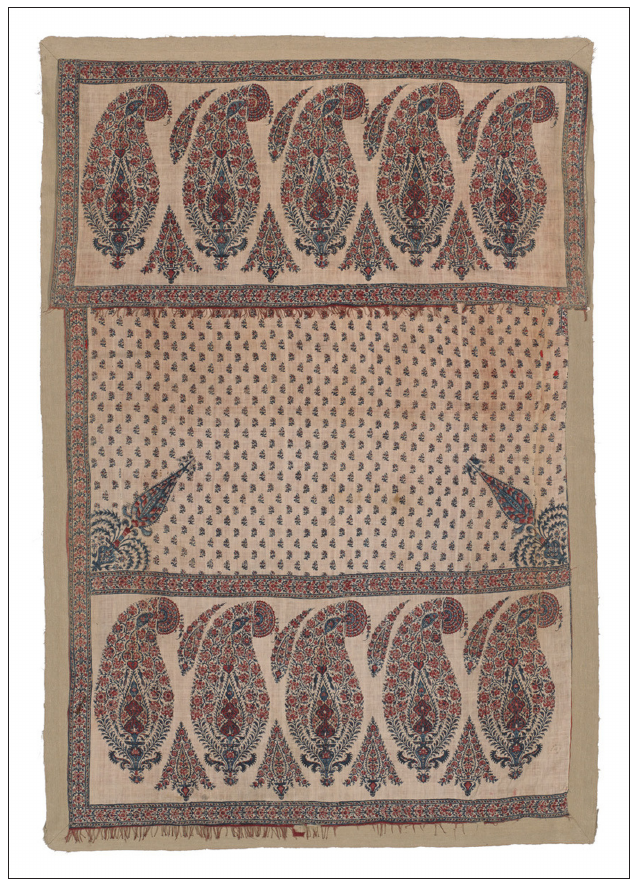
Fig. 5 : Tent panel, hand-printed on cotton, Iran, nineteenth century. T13, given by Miss E. G.Tanner in 1927. © Holburne Museum, Bath. Photo: